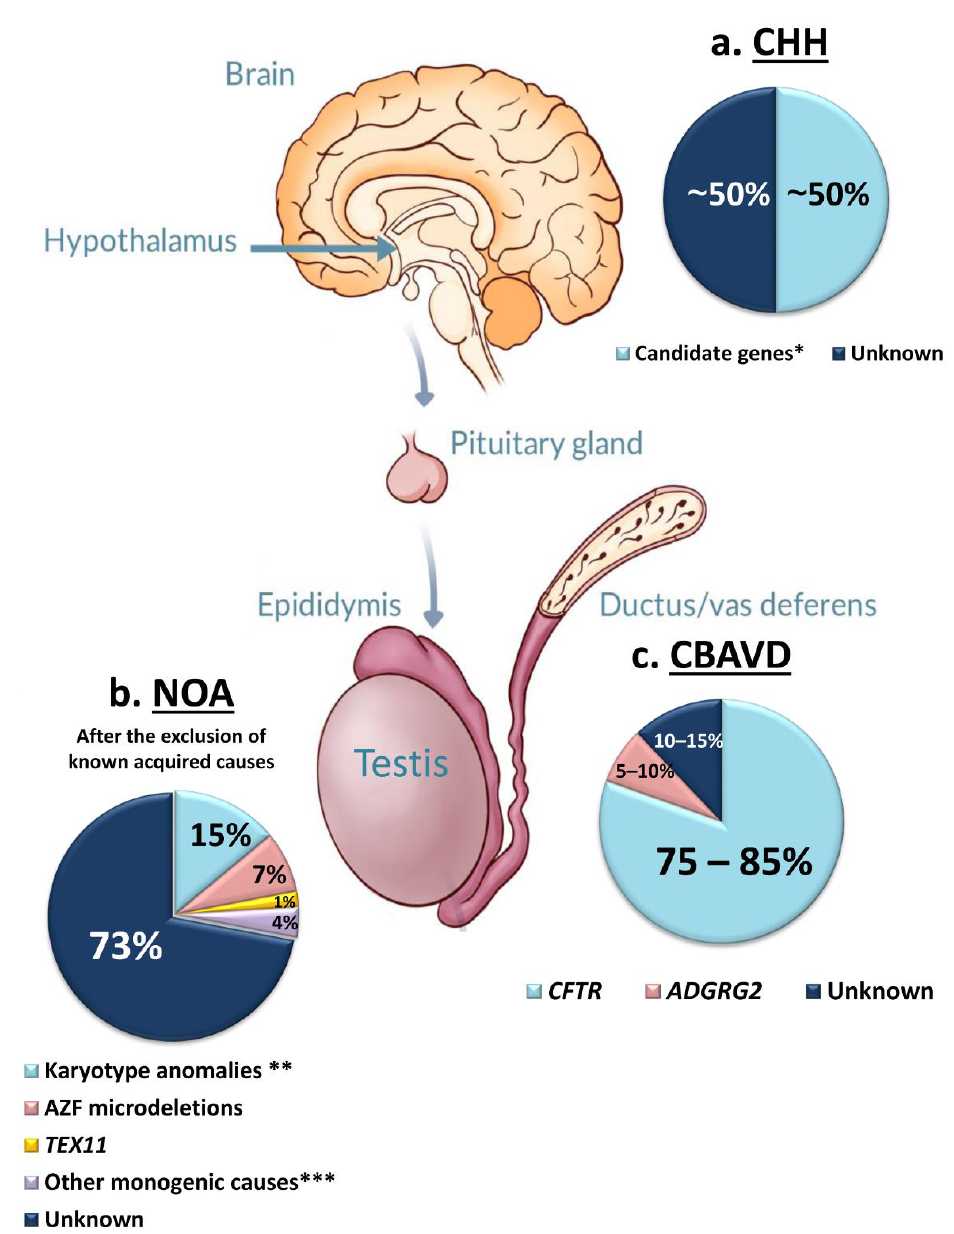
Figure 1. Diagnostic yield of genetic testing in azoospermia with different etiology: ( a ) Congenital Hypogonadotropic Hypogonadism; ( b ) Non-Obstructive Azoospermia due to primary testicular failure, after the exclusion of all know acquired causes; ( c ) Congenital Bilateral Absence of Vas Deferens. Abbreviations: AZF—Azoospermia Factor Region; CBAVD—Congenital Bilateral Absence of Vas Deferens; CHH—Congenital Hypogonadotropic Hypogonadism; NOA—Non-Obstructive Azoospermia; * See Reviews [7,8]; ** 47,XXY Klinefelter syndrome, 46,XX male syndrome, Yq’-‘; *** See articles [9–11].